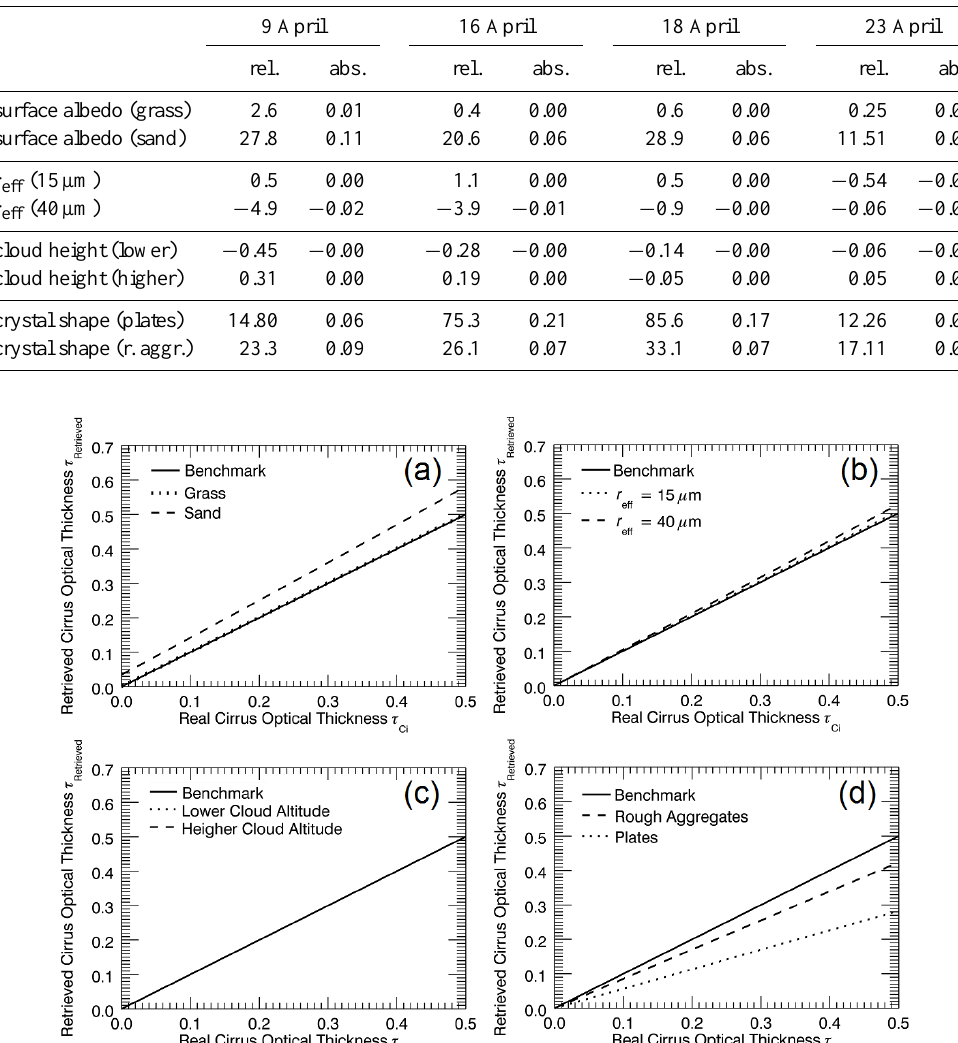
Fig. 15. Retrieval curves for the explanation of the sensitivity results concerning the (a) surface albedo, (b) effective radius, (c) cloud height, and (d) ice crystal shape. Calculated for 30 ◦ solar zenith angle, 90 ◦ solar azimuth angle, solid columns, 11–13km cloud height, surface albedo for water and 20µm effective radius. The benchmark case represents the one-to-one line.